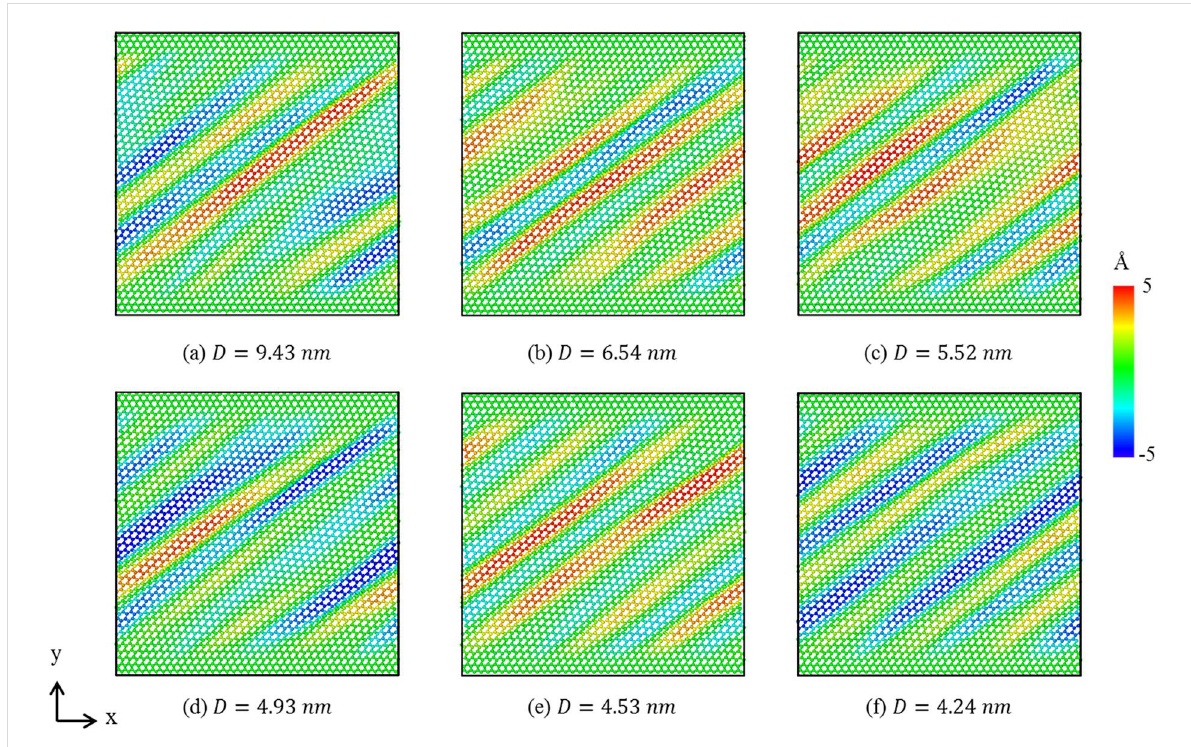
Figure 17: The out-of-plane displacement of zigzag graphene in GPCuNL composites with different grain